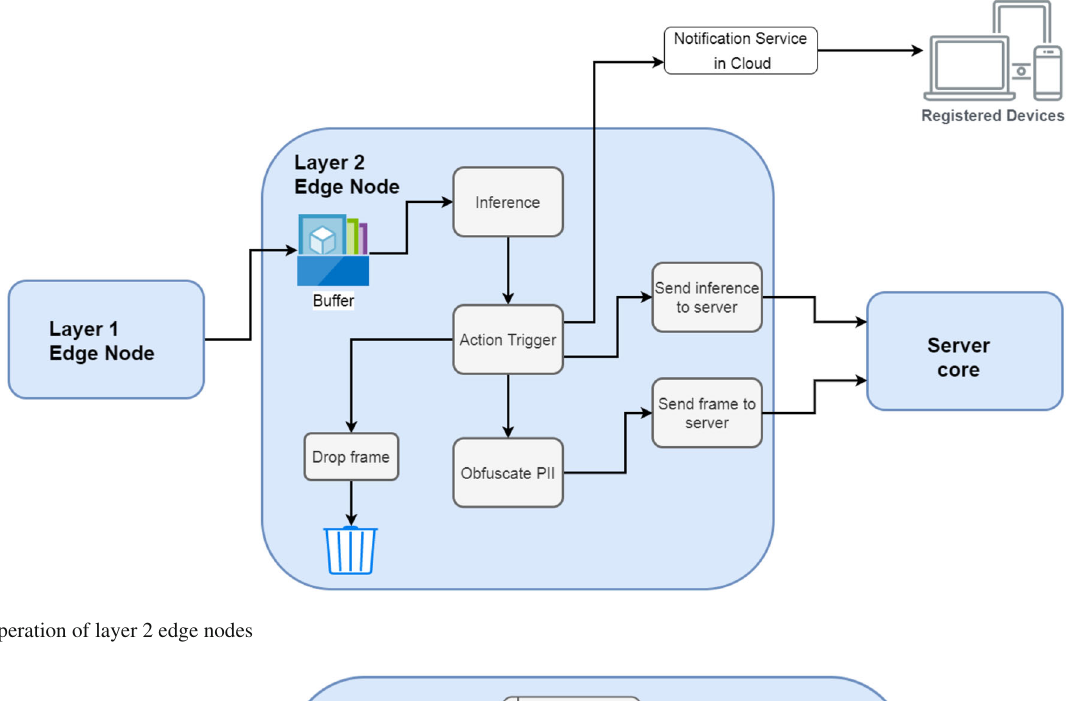
Fig. 4 Operation of layer 2 edge nodes